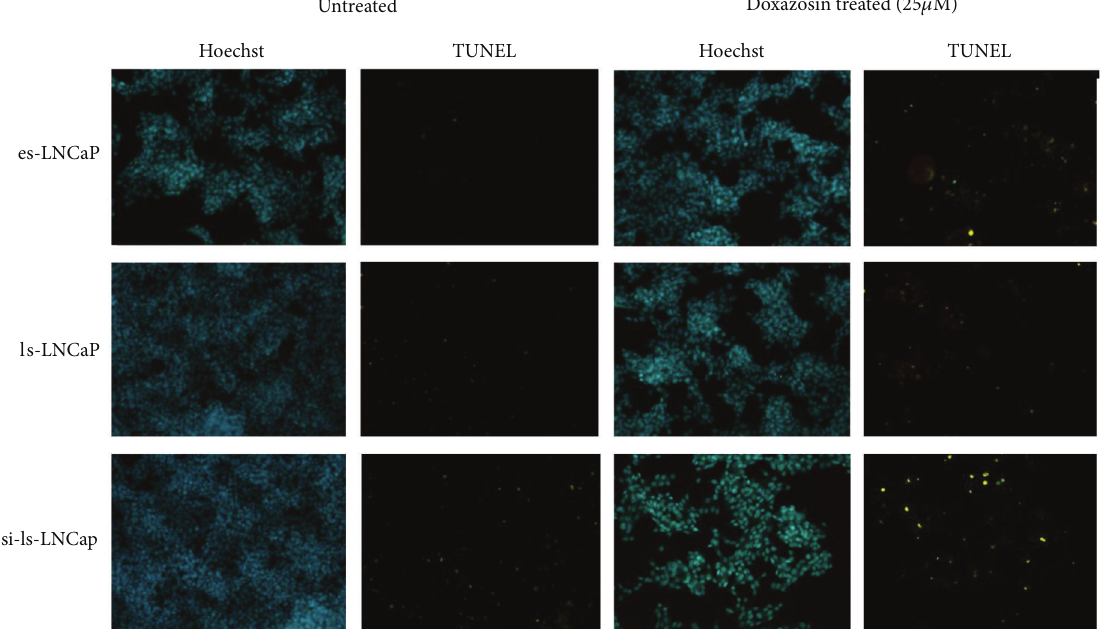
Figure 5: In situ detection of apoptotic cells in AR siRNA transfected cells at 48 hours after doxazosin treatment (25 𝜇 M). In situ detection of apoptotic cells in LNCaP cells was performed by 3 󸀠 -end labeling with digoxigenin-dUTP using terminal